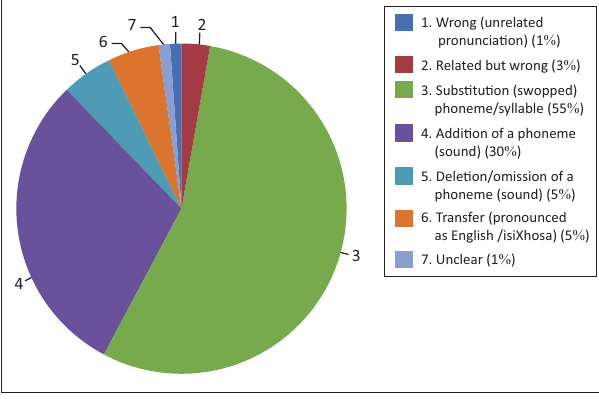
FIGURE 4: School X isiXhosa pseudo-word reading ( n = 87). Sublexical decoding strategies.